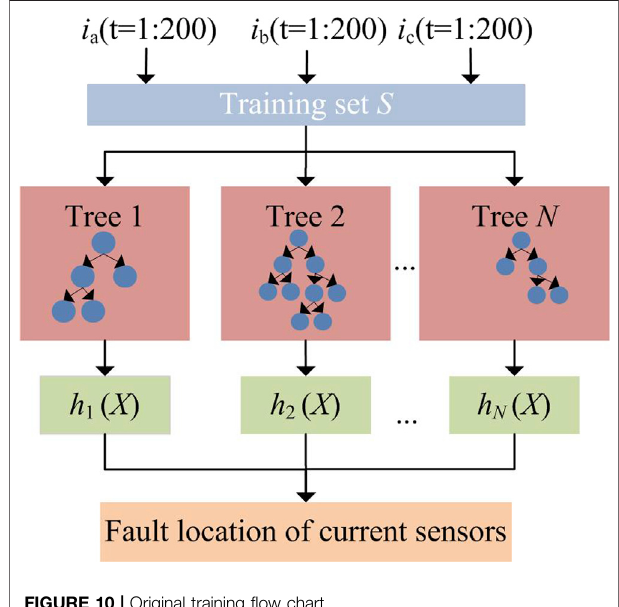
FIGURE 10 | Original training fl ow chart.